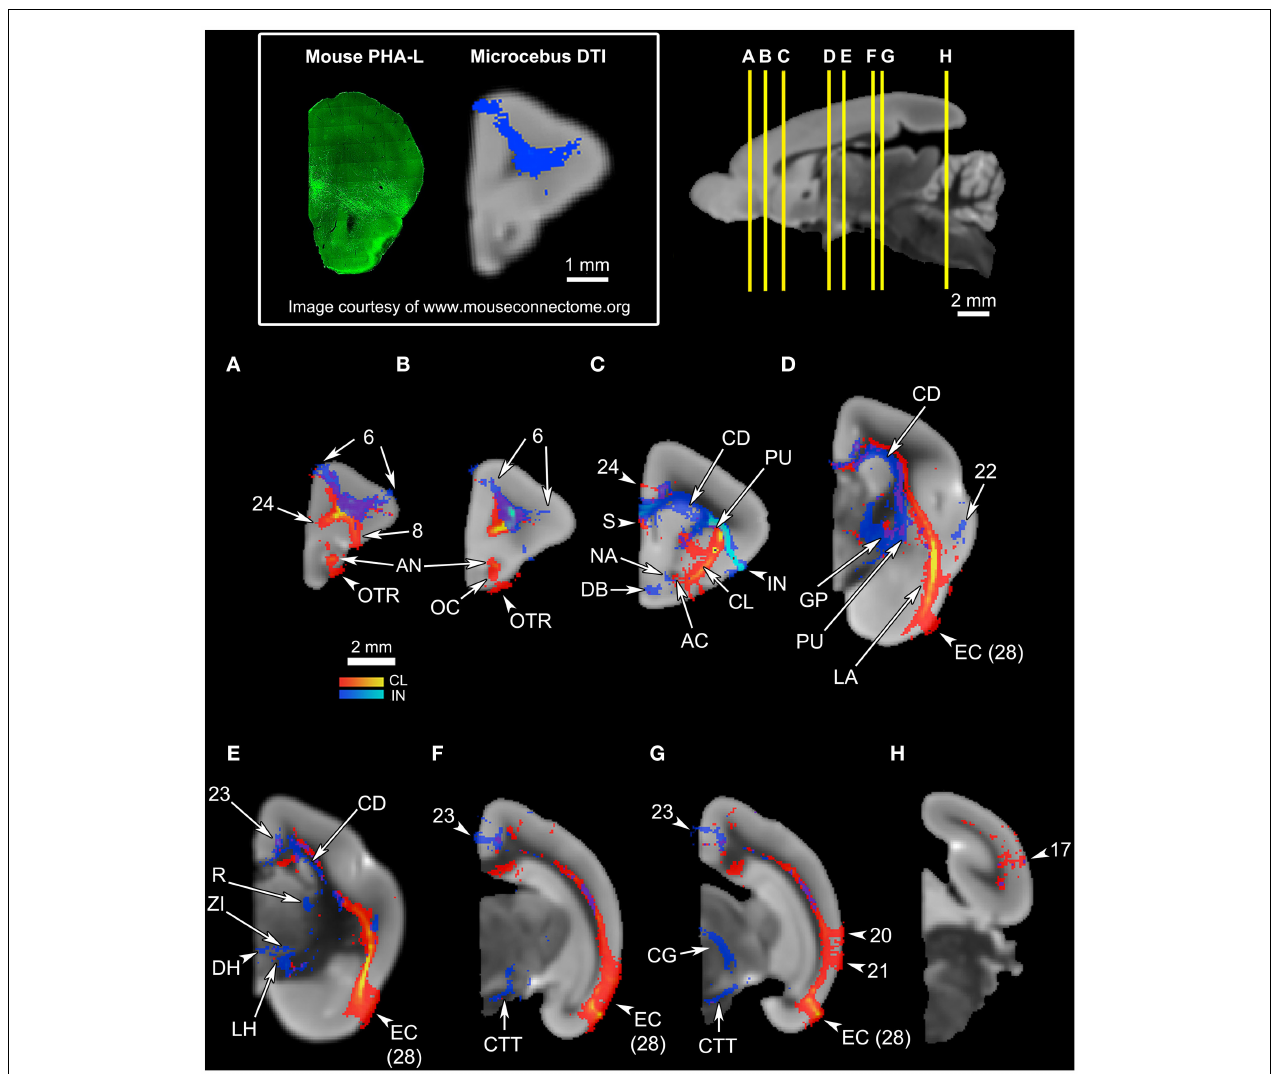
as the septum (S), anterior commissure (AC), and the ventral anterior cingulate cortex.The insular (IN) tracts appear in the caudate (CD), putamen (PU), septum (S), ventral cingulate cortex, nucleus accumbens (NA), and the diagonal band (DB). (D) The claustrum associates with the entorhinal cortex (EC, Area 28 in Le Gros Clark’s, 1931 cortical map) at a high probability, and with the lateral amygdala (LA).The insula connects with the temporal cortex, globus pallidus (GP), caudate (CD), and putamen (PU). (E) The claustrum connects at a high probability to the entorhinal cortex (EC, Area 28 in Le Gros Clark’s, 1931 cortical map).The insula connects to the caudate (CD), cingulate cortex, reticular thalamic nucleus (R), zona incerta (ZI), and dorsal lateral hypothalamus (DH, LH). (F) The claustrum continues to connect at a high probability with the entorhinal cortex (EC, Area 28 in Le Gros Clark’s, 1931 cortical map), whereas the insular tracts appear in the cingulate cortex and along the central tegmental tract (CTT). (G) While the claustrum connects to the entorhinal cortex (EC, Area 28 in Le Gros Clark’s, 1931 cortical map) and the more dorsal cortical areas 20 and 21, the insula continues to associate with the cingulate and central tegmental tract (CTT), and connects with the midbrain central gray (CG). (H) Both claustrum and insula connect with the visual cortex, although the insula does to a significantly lesser degree than does the